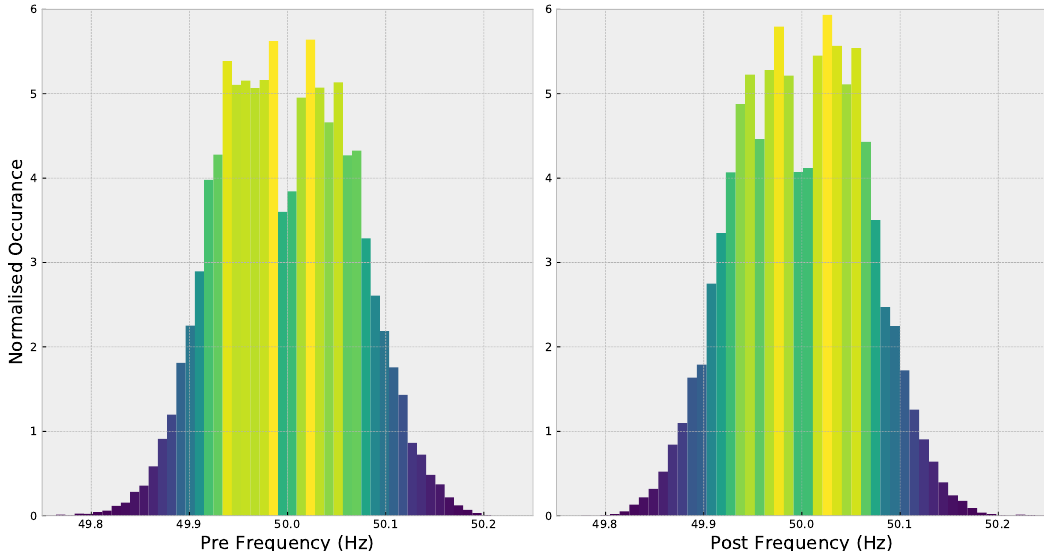
Figure 8. Comparison of pre- and post-action system frequency histograms. The plot on the left represents w/c 02/03/20 and the one on the right represents w/c 23/03/20. The post-action frequency distribution is concentrated more in the range of 49.9 to 50.1 Hz.